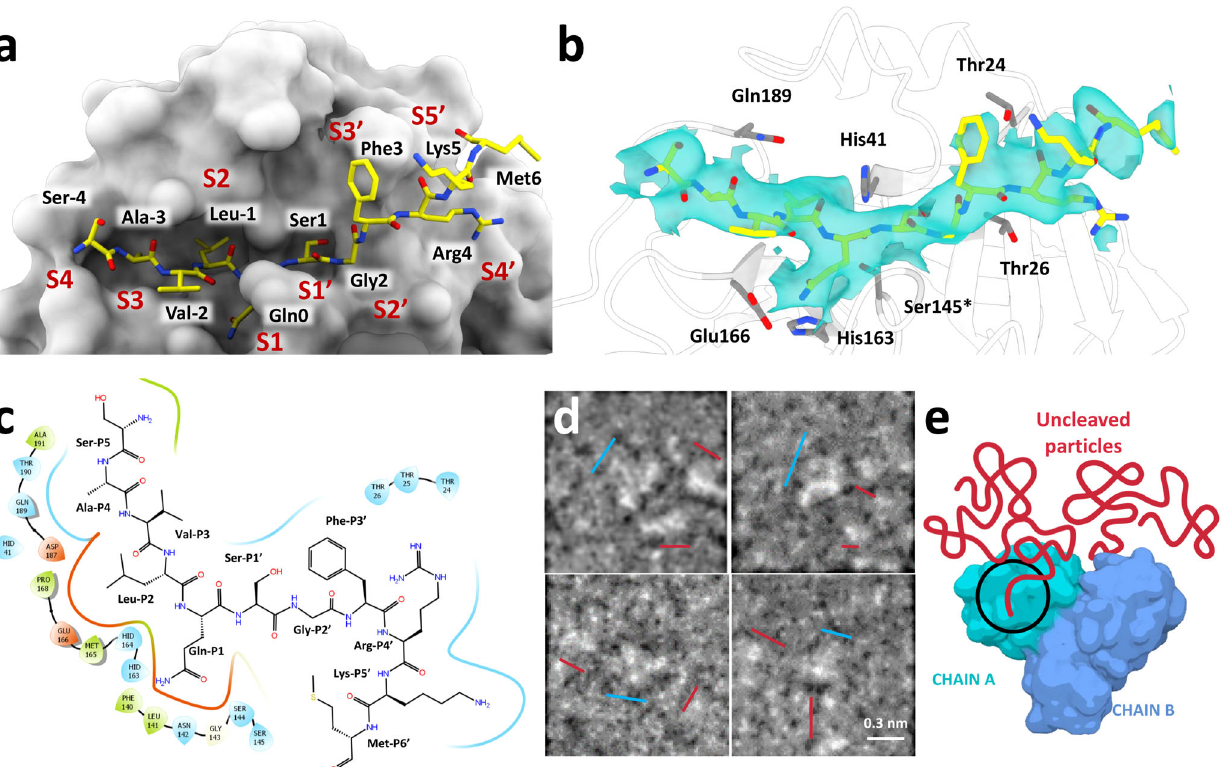
Fig.4|DetailedviewonM pro C145Speptideinteraction.a ActivesiteviewofM pro C145SchainAsurface(ingrey)boundtonsp4-nsp5peptide(yellowsticks).Subsites are denotated from S4 to S5 ’ . b Detailed view of M pro C145S chain A active site residues (in grey) bound to nsp4-nsp5 peptide (yellow sticks), with cryo-EM map showedassurface(contourlevelof4.55). c Interactionschemebetweennsp4-nsp5